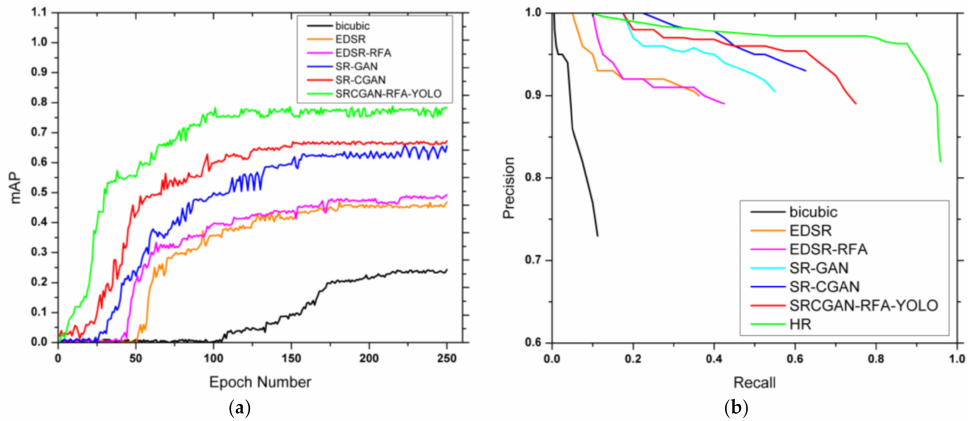
Figure 10. Performance evaluation of various methods used in this study based on AP and preci- sion/recall curves with a YOLOv3 detector and an IoU of 0.10. ( a ) AP of the various methods during training; ( b ) precision versus recall curves.